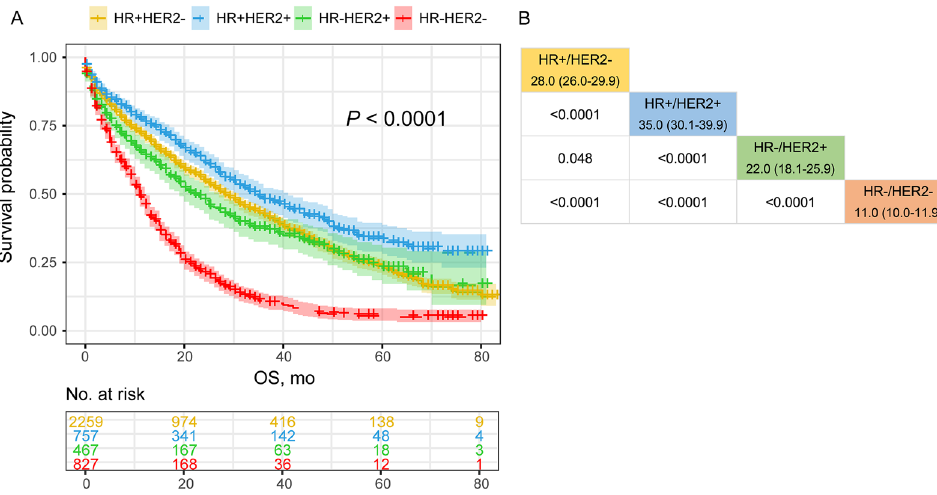
Figure 1. Comparative analysis of OS associated with molecular subtypes. (R software version 3.6.4, www.r- proje ct.